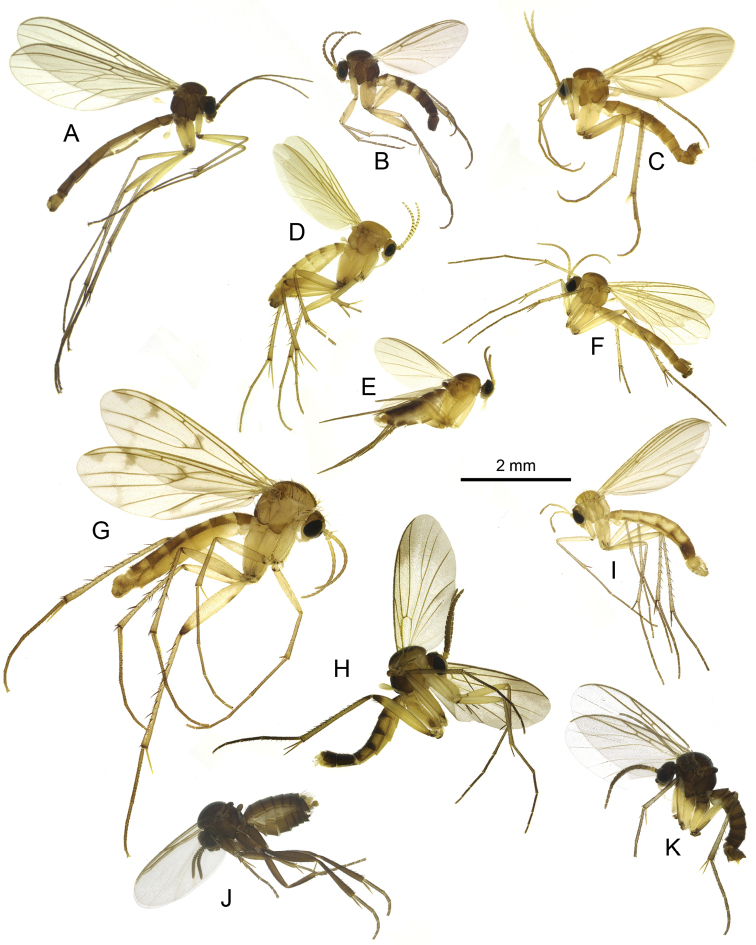
Habitus of Georgian fungus gnats of the family MycetophilidaeABoletina
trivittata (Meigen, 1818) BSynapha
fasciata Meigen, 1818 CGrzegorzekia
collaris (Meigen, 1818) DClastobasis
loici Chandler, 2001 EManota
unifurcata Lundström, 1913 FMegalopelma
nigroclavatum (Strobl, 1910) GLeia
winthemii Lehmann, 1822 HAllocotocera
pulchella (Curtis, 1837) ICoelosia
flava (Staeger, 1840) JNovakia
scatopsiformis Strobl, 1893 KEctrepesthoneura
hirta (Winnertz, 1846).